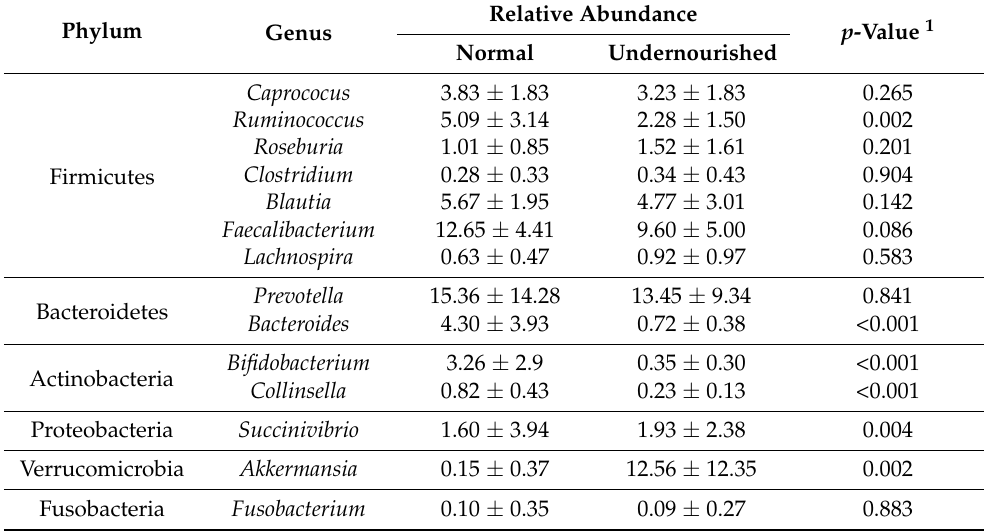
Table 4. Genus-level gut microbiota composition of 40 Indonesian subjects.